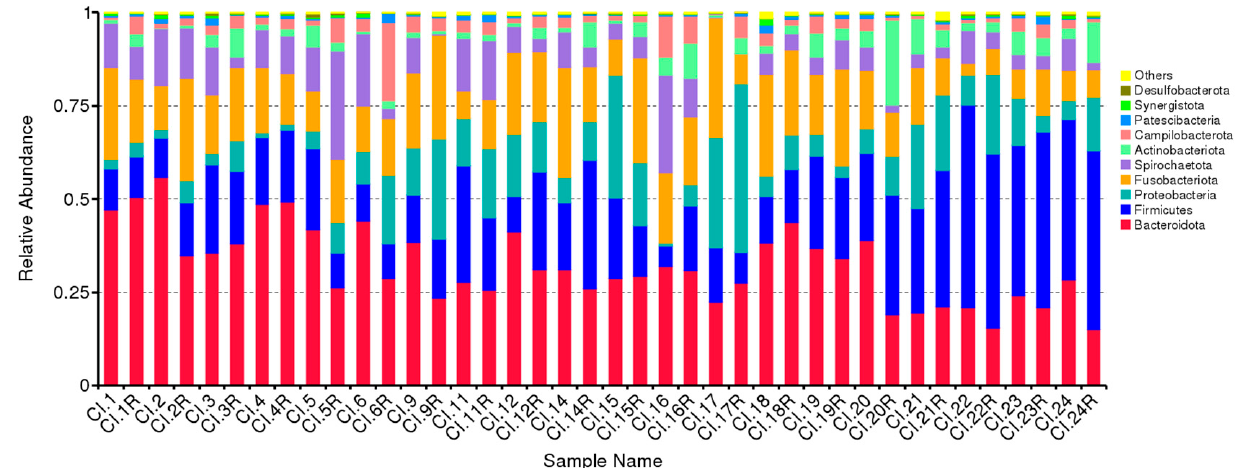
Figure 1. Predominant bacterial taxa phylum in subgingival plaque. Each variable of the Sample Name is named without R (baseline) and with R (follow-up).